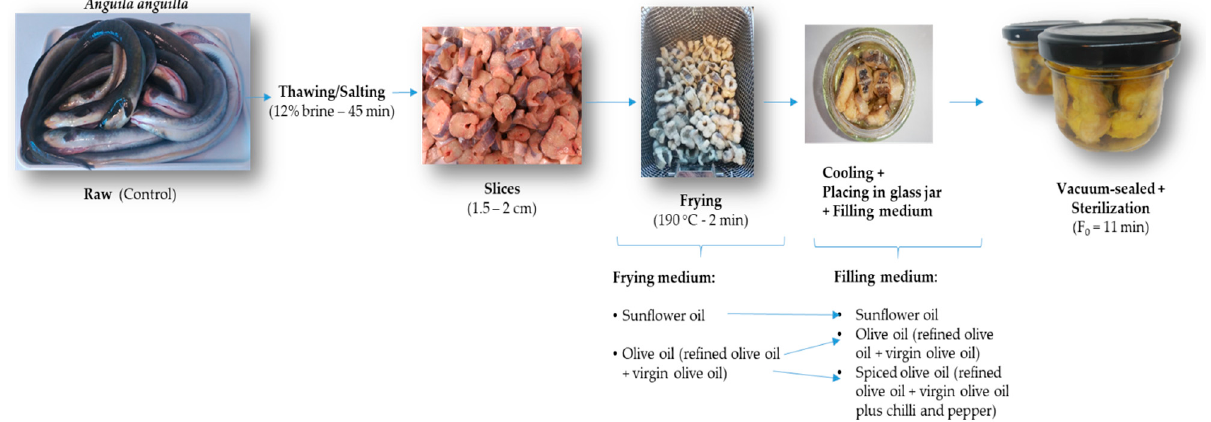
Figure 1. Flow chart of the canned eel production